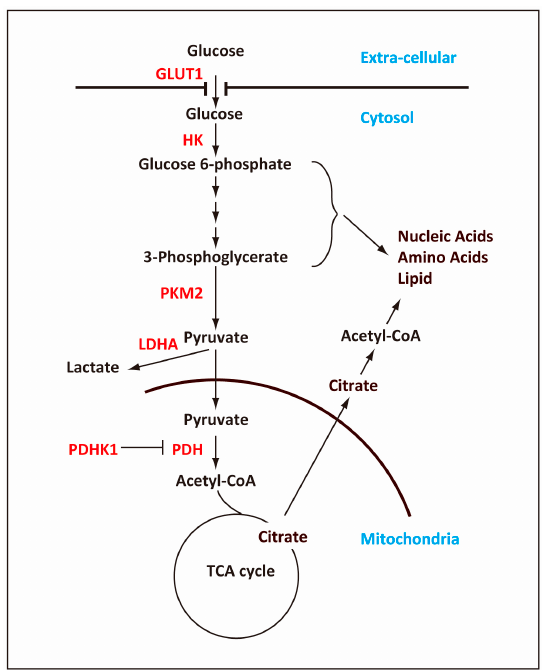
Figure 1. Outline of the glycolytic pathway and TCA cycle. The cell uses glucose transporter, GLUT1, to take up glucose, which is metabolized ultimately to pyruvate in the glycolytic pathway, producing 2 ATP molecules per one glucose molecule. In pluripotent stem cells (PSCs), a majority of glucose-derived pyruvate is converted to lactate and secreted out of the cell while some of pyruvate is transported into mitochondria and converted into acetyl-coenzyme A (acetyl-CoA). The pathways that are connected with the glycolytic pathway produce ribose, nicotinamide adenine dinucleotide (NADPH), and amino acids, which are required for rapidly proliferating cells such as PSCs and cancer cells. In mitochondria, acetyl-CoA is converted into citrate, which, in addition to oxidization in the TCA cycle, will be transported out of the mitochondria into the cytosol and converted back into acetyl-CoA. The cytosolic acetyl-CoA is important for reactions such as lipid synthesis and histone acetylation. Key enzymes that are regulated in the glycolytic pathway are indicated in red. Arrows indicate the flow of metabolites, and the T bar indicated negative regulation of PDH by PDHK1.